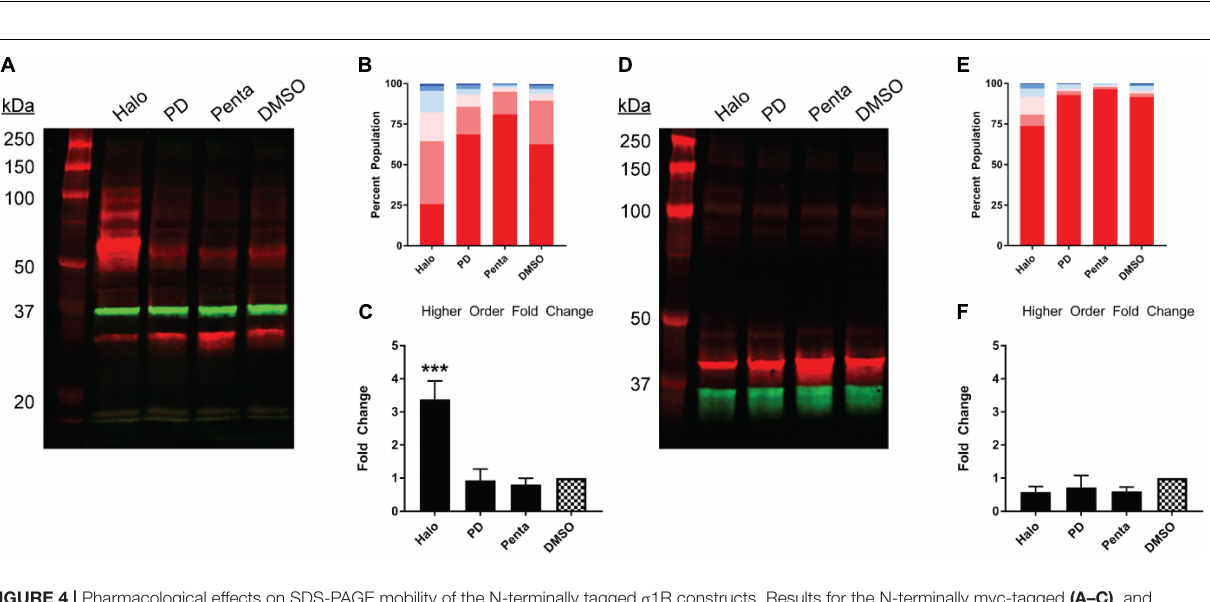
FIGURE 3 | SDS-PAGE mobility comparison among the unmodified and N-terminally tagged σ 1R constructs. (A,B) Red bands are visualized by anti- σ 1R (A) or anti-myc (B) antibodies and green bands are visualized by anti-GAPDH (A,B) antibodies on 10% SDS-PAGE (protein standard, σ 1R, myc- σ 1R, Nluc- σ 1R, σ 1R KO cells). (C,D) Quantification of band intensities normalized to total signals within each lane for σ 1R (C) and myc (D) blots. (E) Radioligand binding properties of [ 3 H](+)-pentazocine for σ 1R, myc- σ 1R, and Nluc- σ 1R (averaged curves are shown in Supplementary Figure S4 ). K d and E max values are not statistically different (one-way ANOVA). Each blot image is representative of n > 3 experiments that are averaged in bar graphs.